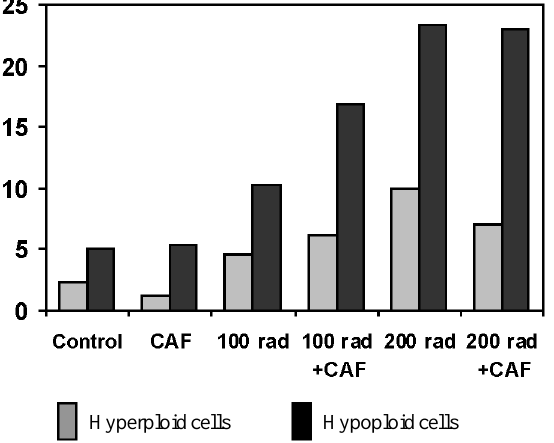
Figure 1 - Frequencies of hyperploid and hypoploid metaphases in CHED cells treated with X-rays (100 and 200 rad) and caffeine (CAF) (200 µ g/ml).